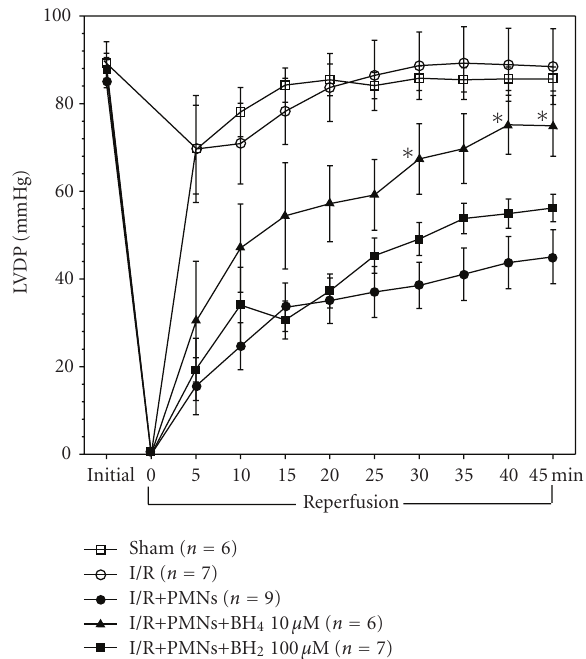
Figure 4: Time course of cardiac function parameters (LVDP) from sham, I/R, I/R+PMN, I/R+PMN+BH 4 (10 μ M), and I/R+PMN+BH 2 (100 μ M) groups. There was no significant di ff erence in baseline values among these groups. The sham group ( n = 6) maintained the same LVDP throughout the 80 minutes protocol. The I/R+PMN ( n = 9) and I/R+PMN+BH 2 ( n = 7) groups exhibited a significant and sustained reduction in LVDP during the 45 minutes of reperfusion compared to sham. I/R ( n = 7) and I/R+PMN+BH 4 ( n = 6) groups exhibited significant restoration of LVDP during the 45 minutes reperfusion compared to I/R+PMN group. All values are expressed as mean ± SEM. ( ∗ P < . 05, from I/R+PMN values).